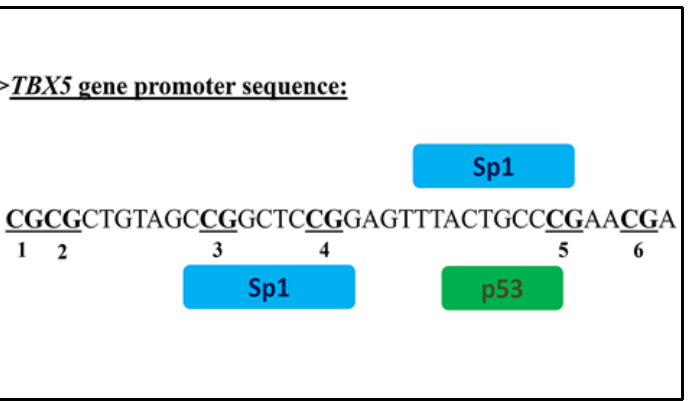
Figure 5. The potential binding sites of transcription factors identified with PROMO, TFBIND and AliBaba 2.1 software.